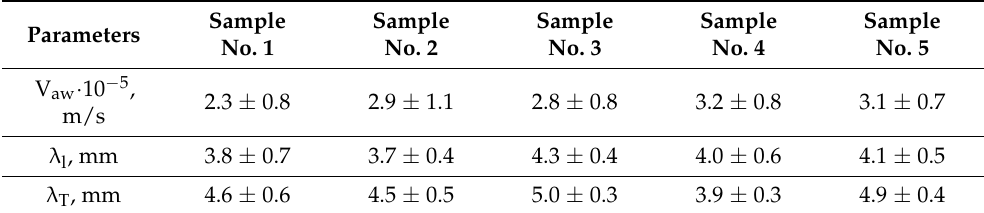
Table 2. Degrees and gradients of reduction at the rolling